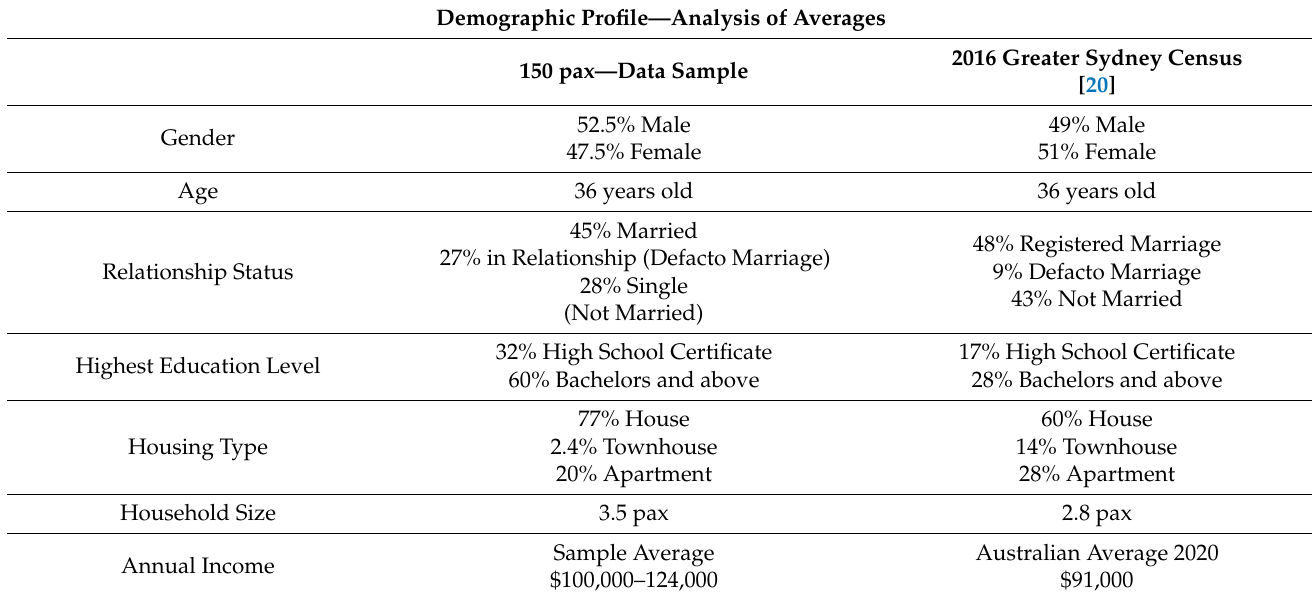
Table 2. Respondent Demographic